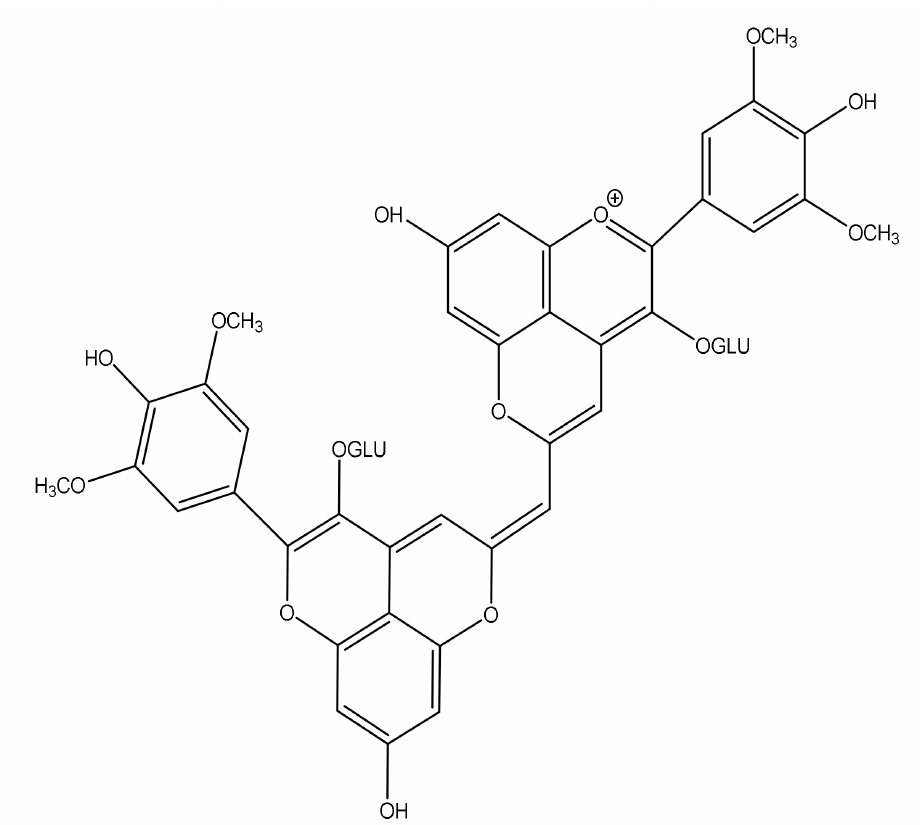
Figure 5. Structure of pyranoanthocyanin